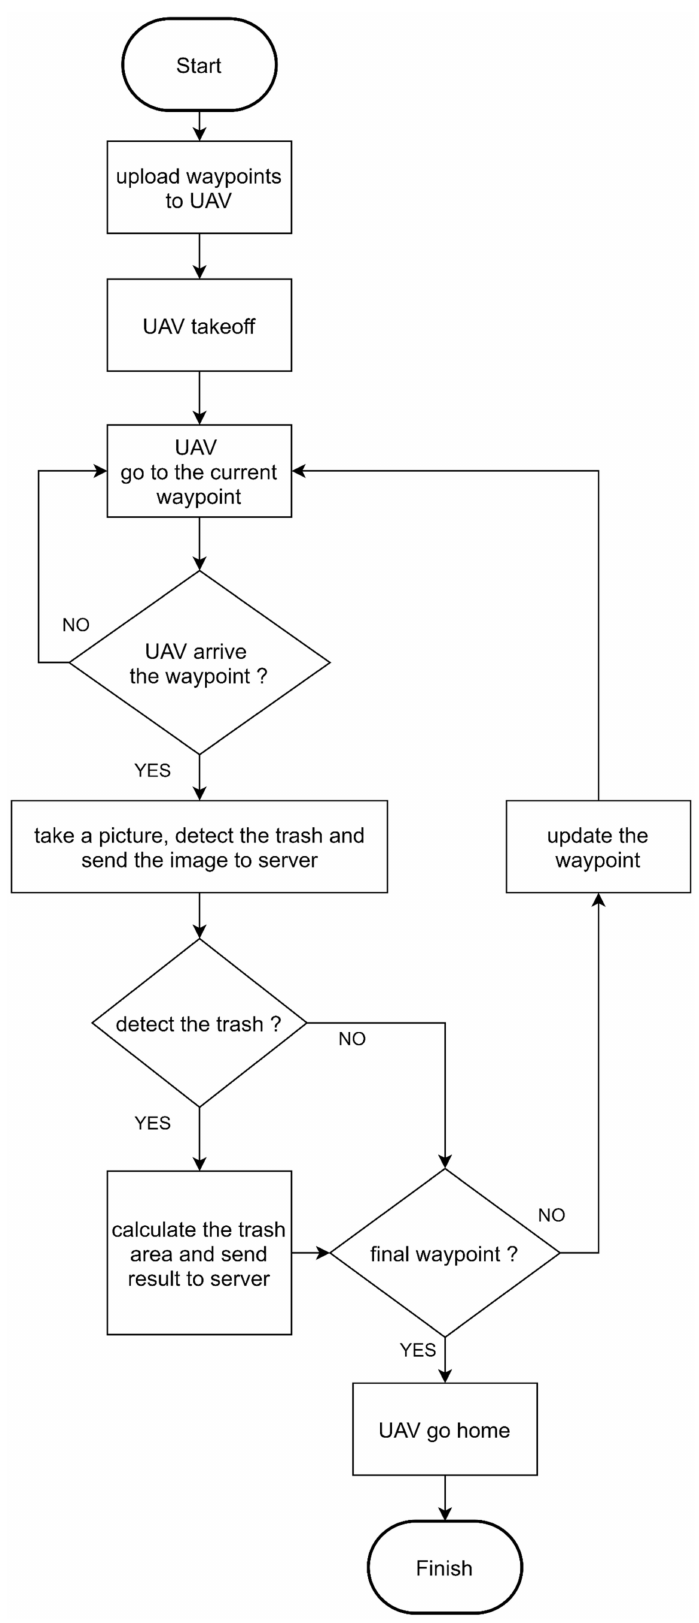
Figure 5. A flowchart of the UAV trash detection